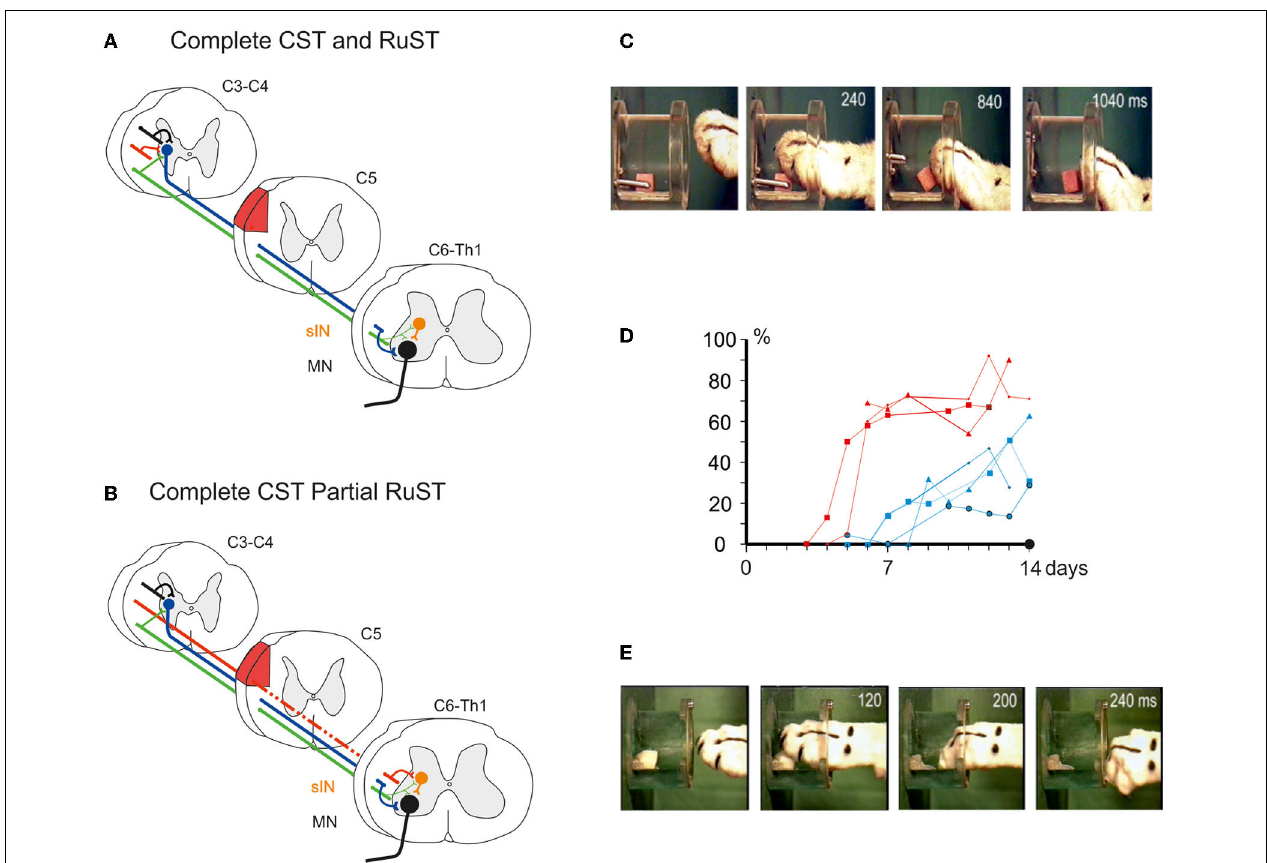
FIGURE 2 | (A) Schematic illustration of pathways remaining after a complete lesion (red area) of the DLF in C5/C6 interrupting the CST and the RuST. (B) , as in (A) , but for an incomplete lesion leaving a small fraction of RuST fibres intact. (C) , Loss of digit grasping after the lesion in (A) (6 days postoperatively). (D) Percentage of trials with successful digit grasping in different experiments during the initial two postoperative weeks after lesion